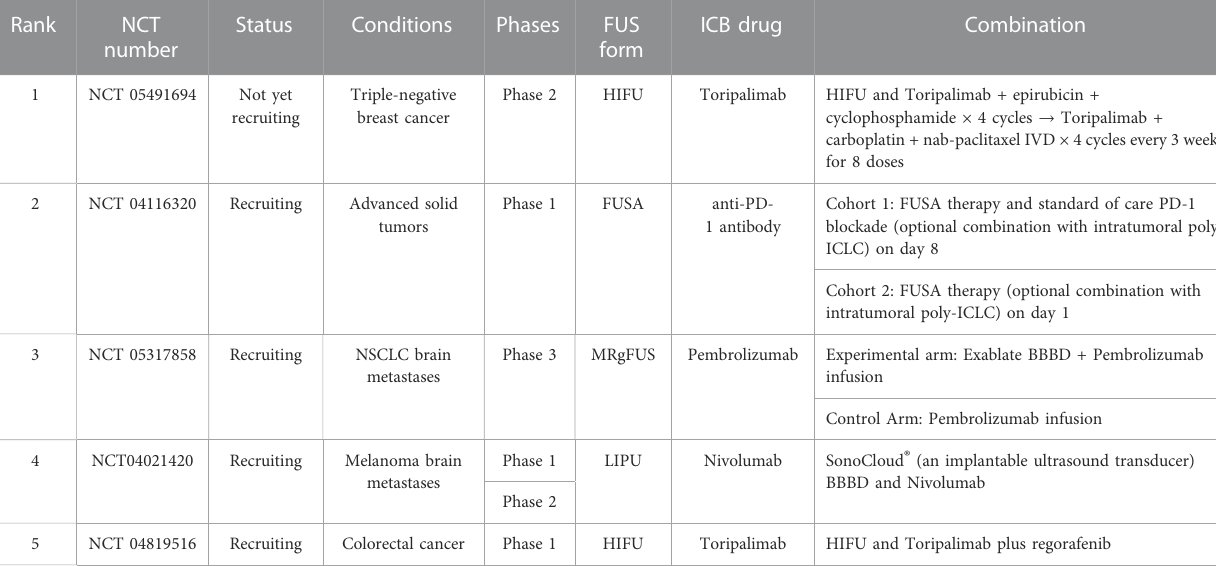
TABLE 2 Clinical trials of FUS and ICB combination therapy in solid tumors.